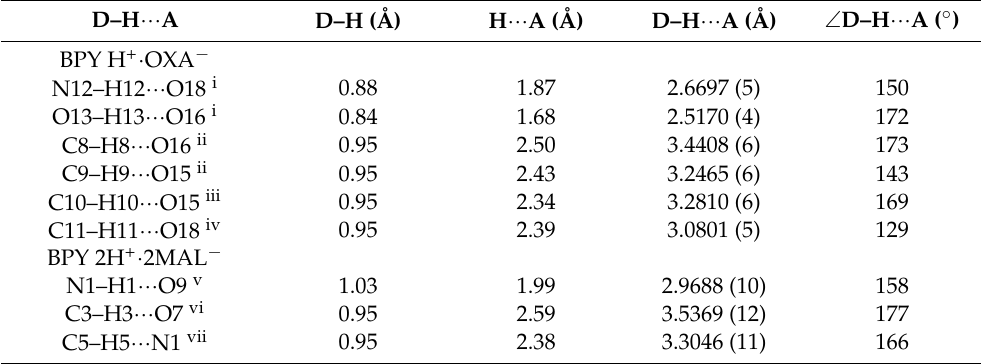
Table 2. Hydrogen bond details and short contacts for BPY H + ·OXA − and BPY 2H + ·2MAL − .